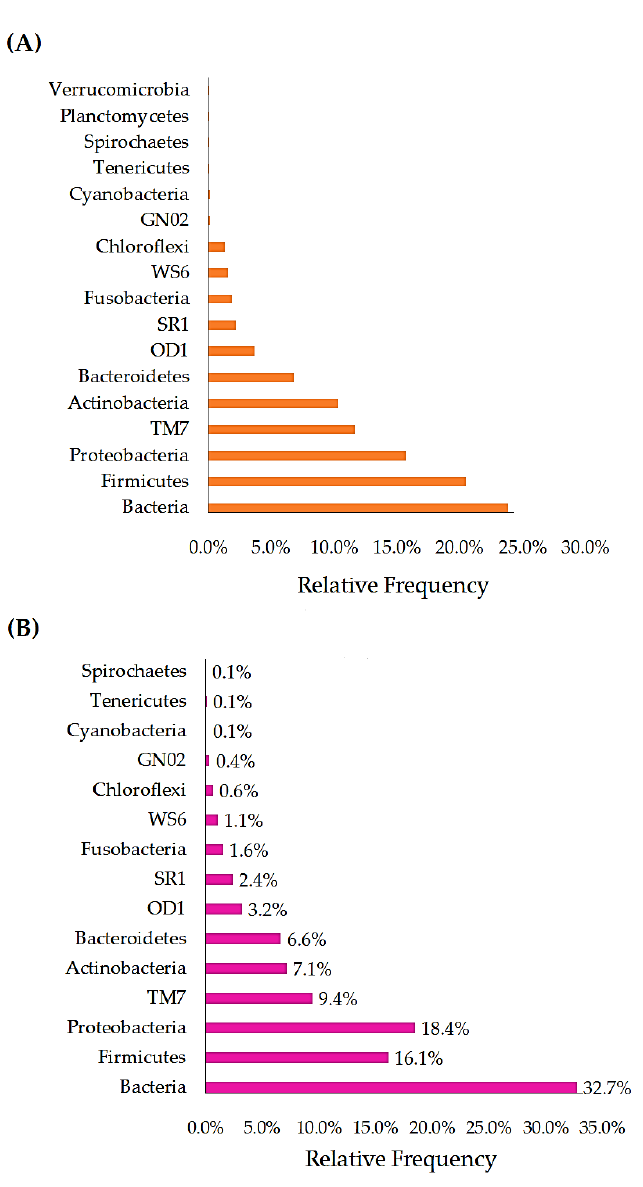
Figure 2. Comparison of the phylum-level relative frequency of PrTS ( A ) and PoTS ( B ) of the control group (G1). PrTS: pretreatment samples; PoTS: post-treatment samples. Firmicutes (μ = 22.24%) was found majorly in the PrTS (Figure 3A), whereas the amount of Firmicutes (μ = 16.39%) was decreased in the PoTS (Figure 3B) of G2. However, the phylum Proteobacteria load (μ = 17.88%) was increased in the PoTS of G2 and it was identified as the major phylum. The phyla Bacteria (μ = 24.41%), Firmicutes (μ = 22.24%), Proteobacteria (μ = 13.46%), TM7 (μ = 14.94%), Actinobacteria (μ = 8.93%), Bacteroidetes (μ = 5.53%), OD1 (μ = 3.83%), SR1 (μ = 1.71%), Fusobacteria (μ = 1.62%), Chloroflexi (μ =